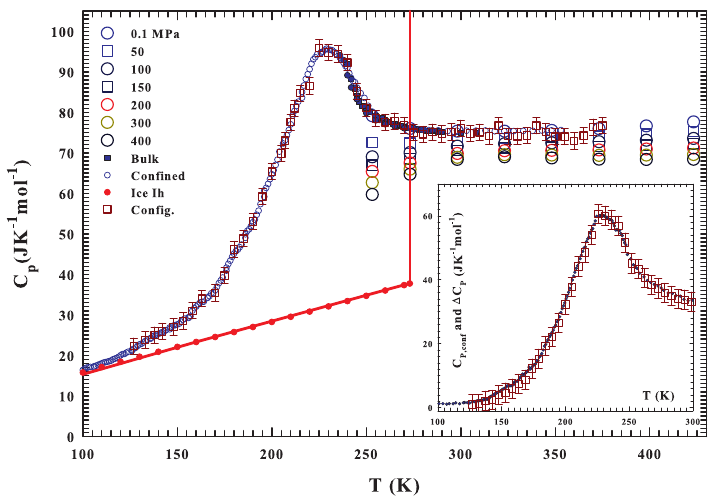
Figure 2. The figure reports the liquid water specific heat C P ( T , P ) , measured in the temperature range 100–430 K for 0.1 MPa, and that of the Ih ice (red lines and dots [50]); for T > 250 K data at P = 50 , 100, 150, 200, 300 and 400 MPa are also reported. For ambient pressure, data come from different experiments in bulk [51,52] and confined water (in nanotubes of 2.2 nm [47]). Data for P > 50 MPa deal instead only with bulk water [53]. The inset shows the difference ∆ C P = C P , liq − C P , sol (squares) and the configurational C P , conf evaluated by using the Adam–Gibbs model